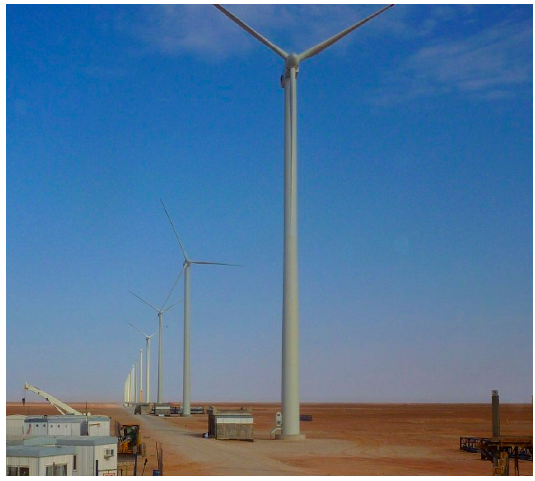
Figure 1. Wind farm at Kabertene in Adrar. Reproduced for reference [5].